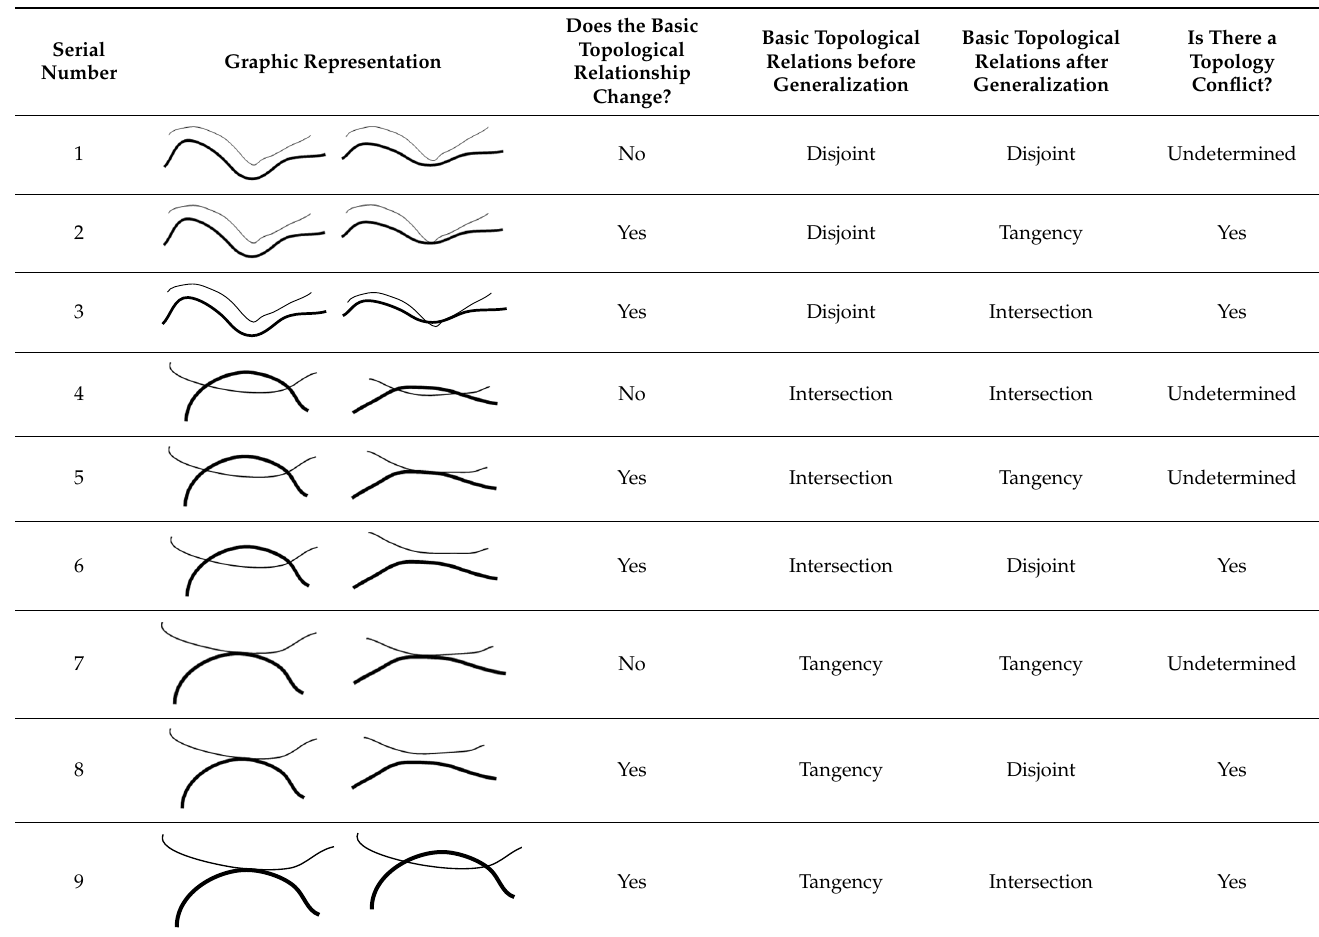
Yes Tangency Intersection Yes